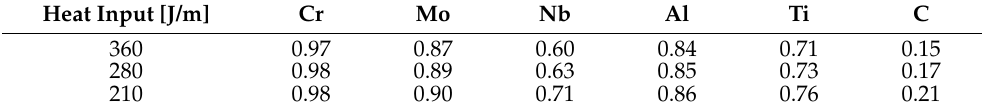
Table 3. Average IN713LC element partition coefficients under different solidification rates. Heat Input [J/m] Cr Mo